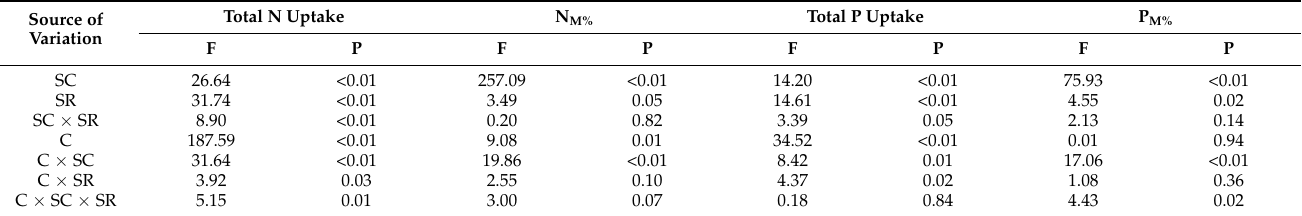
Table 3. Three-way ANOVAs on effects of species combination (SC), sowing ratio (SR), and cut (C) on aboveground total N and total P uptake of lucerne and grasses and proportions of lucerne N (N M% ) and P (P M% ) uptake in aboveground total N and P uptake.